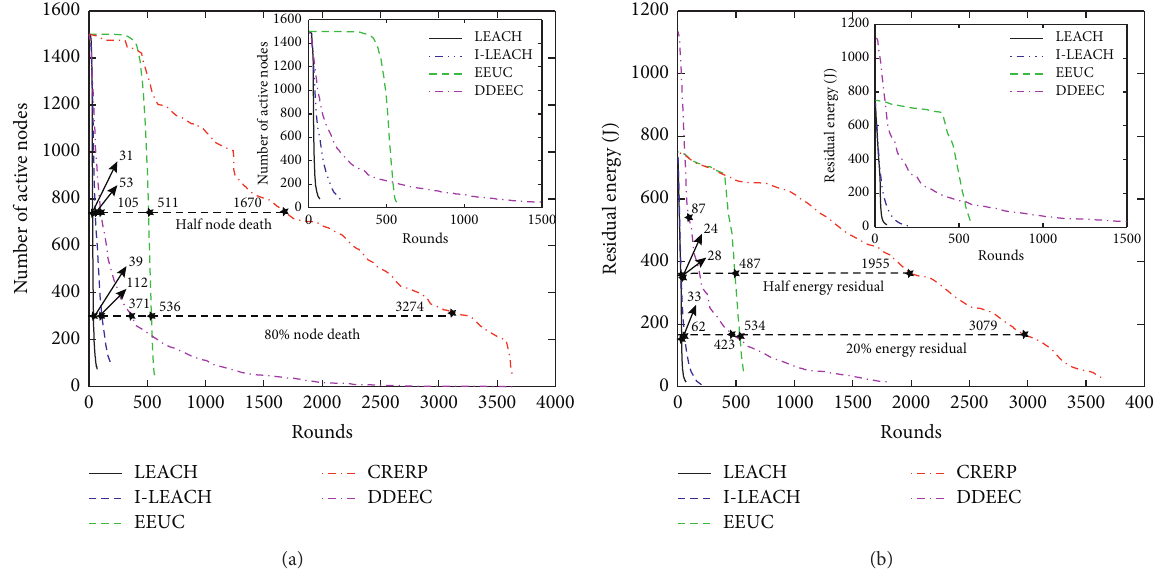
Figure 12: Performance comparisons of CHRERP, LEACH, I-LEACH, EEUC, and DDEEC: (a) number of active nodes with varying simulation rounds and (b) residual energy with varying simulation